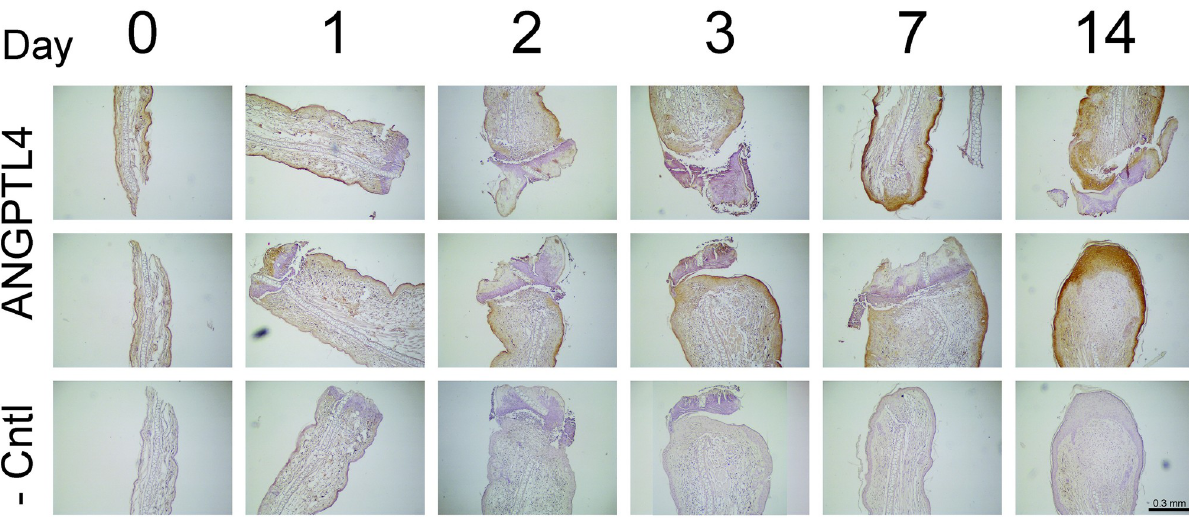
Fig 5. Immunohistochemical staining of ANGPTL4. ANGPTL4 staining (brown) at the wound site immediately (day0) after wounding, and at days 1, 2, 3, 7 and 14 after wounding. Images are representative of n = 3.